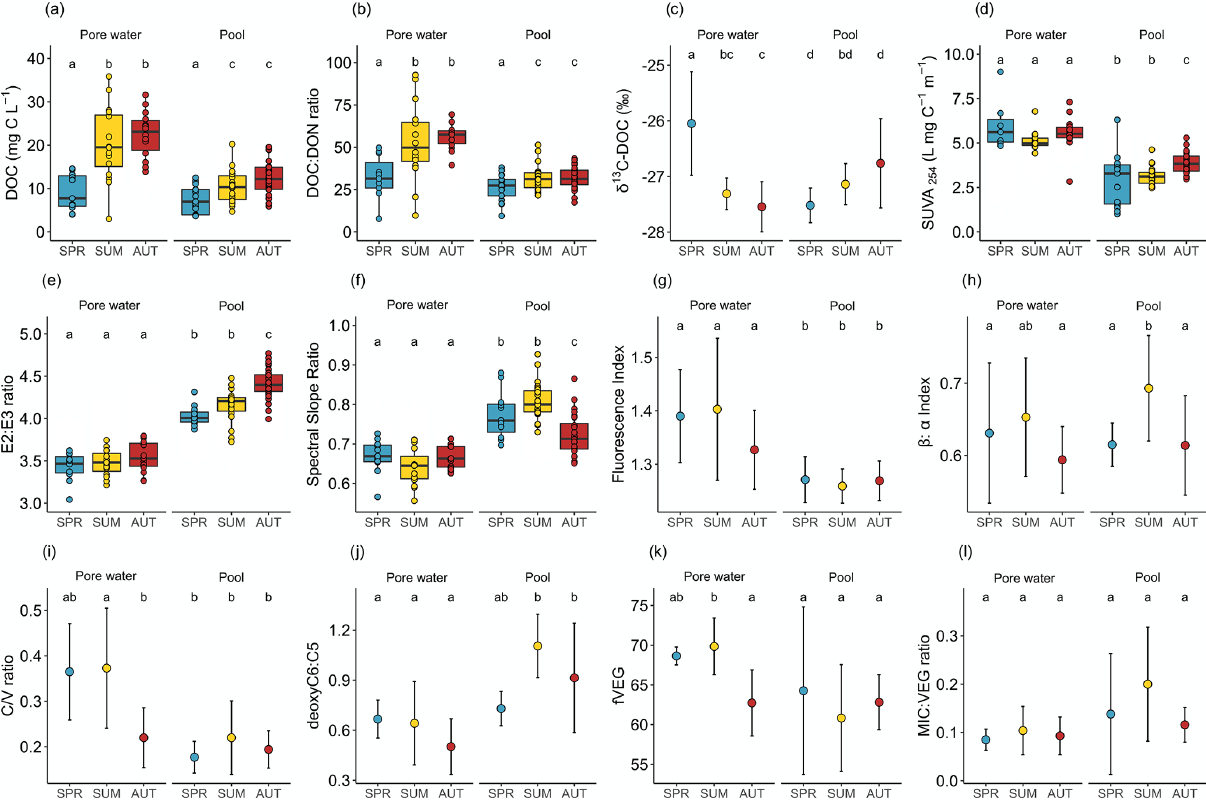
Figure 2. Box plots ( a to b and d to f ) and dot plots ( c and g to i ): (a) DOC concentrations, (b) DOC : DON ratio, (c) δ 13 C-DOC, (d) SUVA 254 , (e) E 2 : E 3 ratio, (f) spectral slope ratio, (g) fluorescence index, (h) β : α index, (i) C/V ratio, (j) deoxyC6 : C5, (k) f VEG, and (l) MIC : VEG ratio. Each plot represents the evolution of variables during the growing season (SPR: spring; SUM: summer; AUT: autumn) in peat porewater and pools. Dot plots were used when n< 5 for at least one season. Error bars represent standard deviations. Box plots were used when n> 5 for each season. The dots represent each individual measurement, and boxes represent the lower (25th percentile) and the upper quartile (75th percentile); the median (50th percentile) is represented by the bold black horizontal bar in the boxes. Whiskers represent the interquartile range. Letters represent the significant differences between seasons. For each individual plot, conditions which share a letter do not present statistical